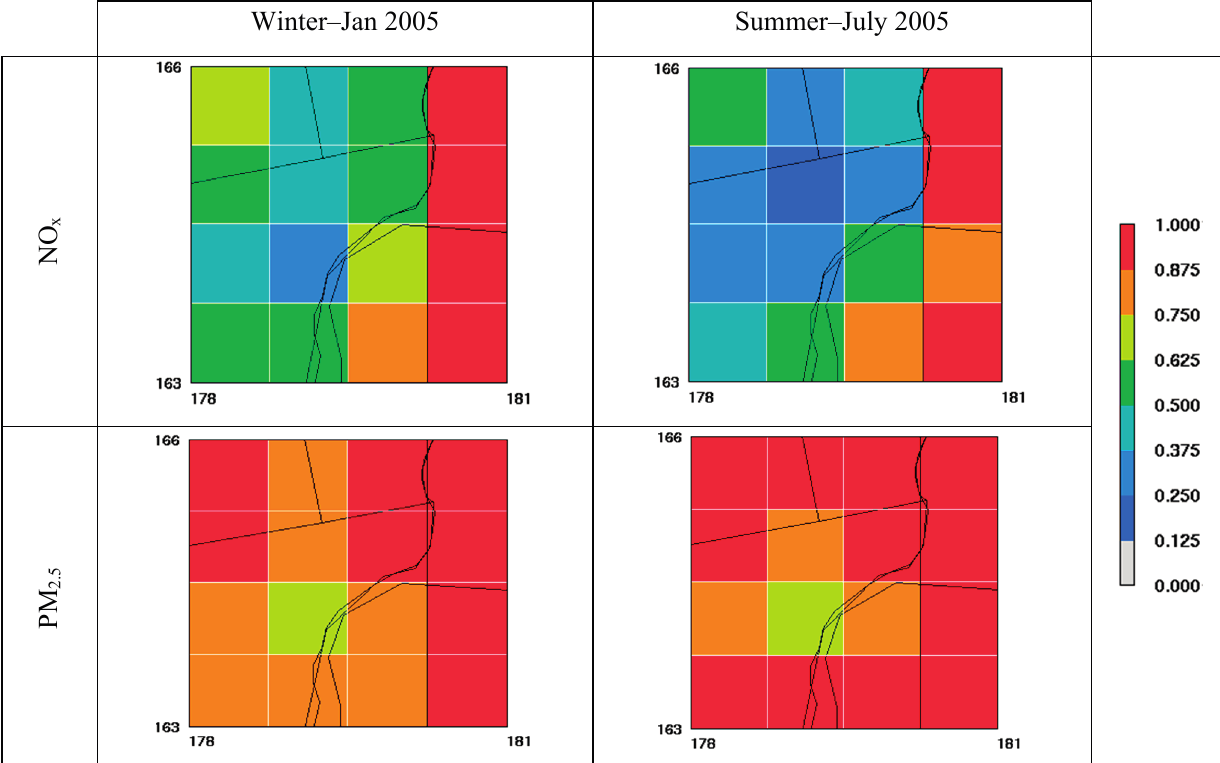
Figure 5. Spatial plots of CMAQ-based R ZeroOut/Total for NO x and PM 2.5 for summer and winter at the 16 cells where local emissions were